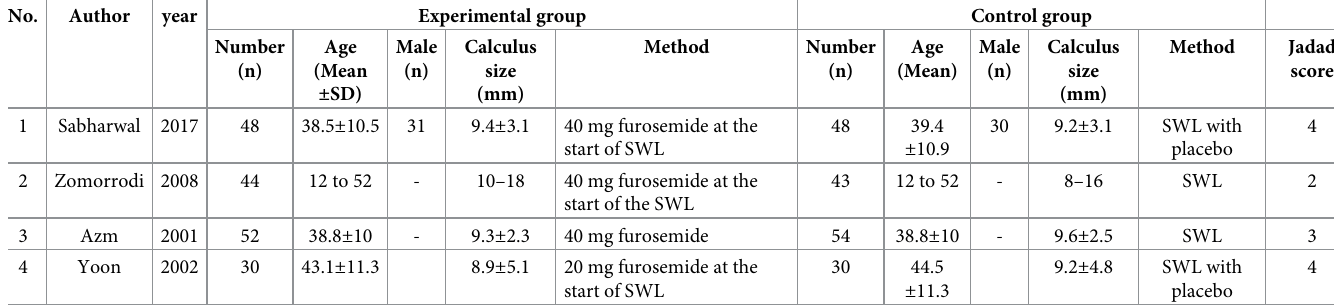
Table 1. Characteristics of the included studied.